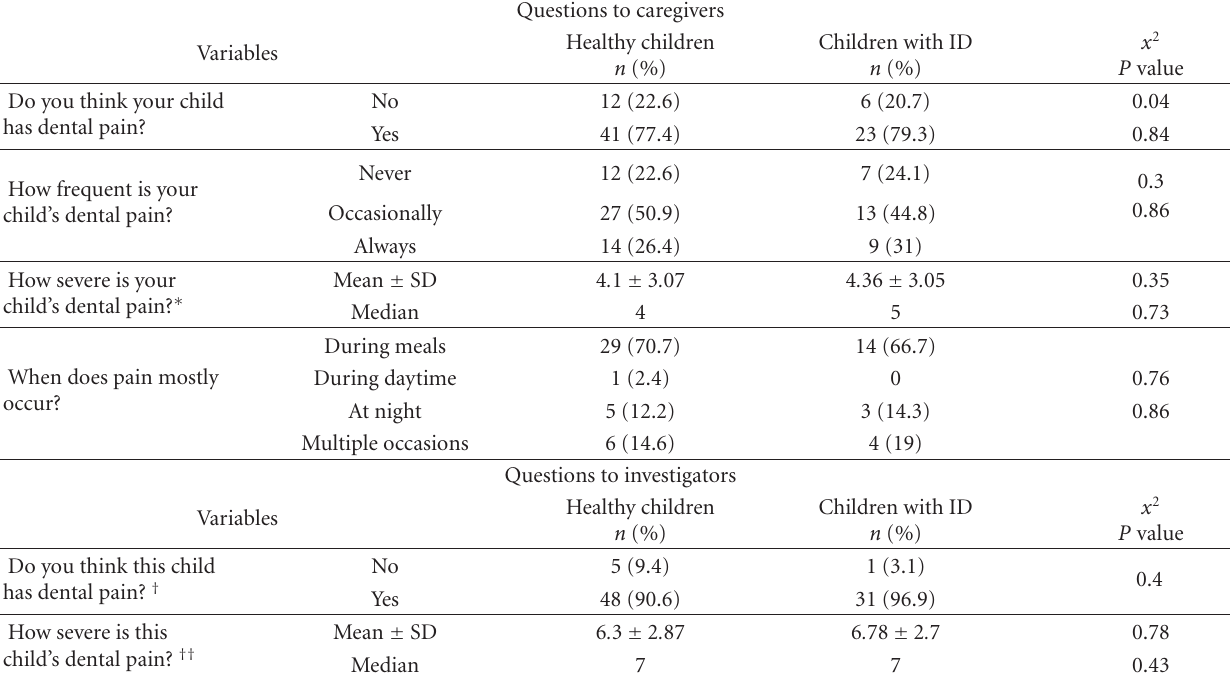
Table 2: Caregivers’ and investigators’ reporting of children’s dental